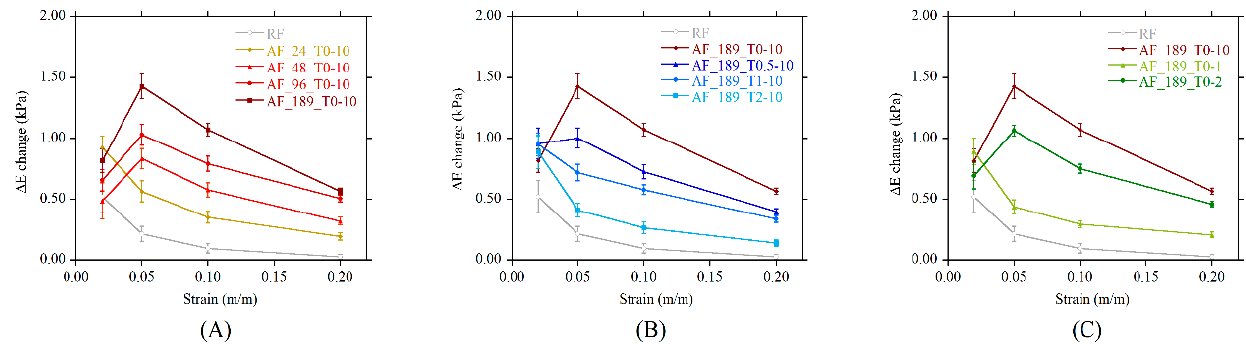
Figure 11. The change in the apparent modulus ( ∆ E-change) versus the prestrain as a function of ( A ) magnetic field strength, ( B ) switch-on time, ( C ) switch-off time.